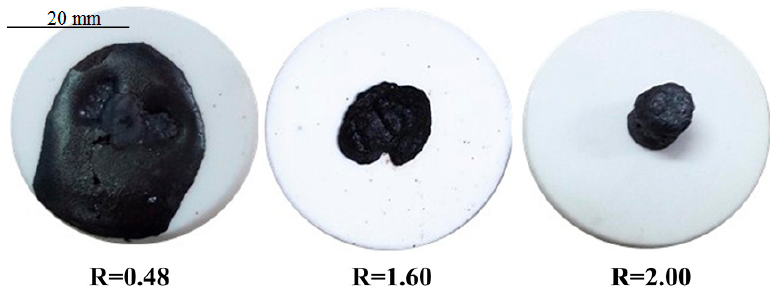
Figure 9. Appearance of the reduced briquette at different basicity ( R = the ratio of CaO to SiO 2 ) (Ore blended with 10% sodium sulfate and reducing at 1350 °C for 10 min with C/Fe = 0.48).